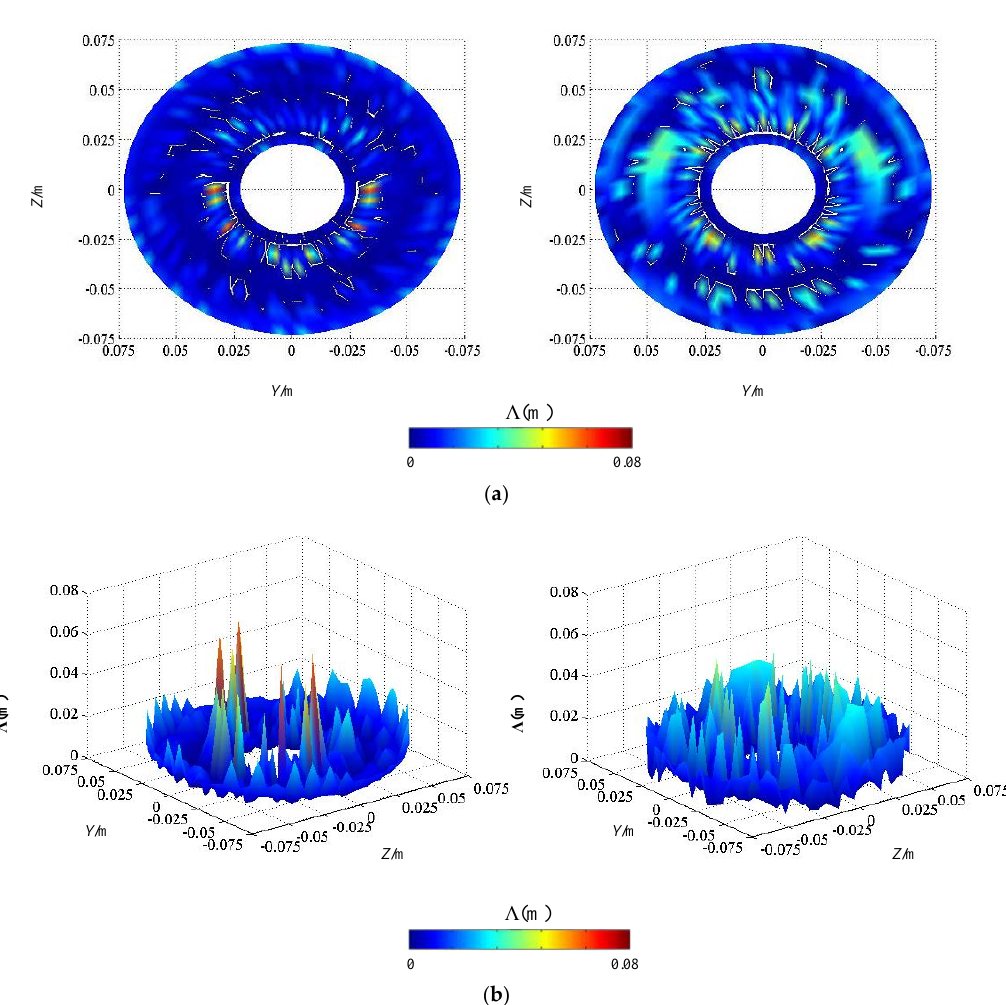
Figure 15. Comparison of turbulence integral scales inside the cavity. ( a ) Two-dimensional turbulence integral scale inside the cavity at 0 °C (left) and 25 °C (right). ( b ) Three-dimensional turbulence integral scale inside the cavity at 0 °C (left) and 25 °C (right).